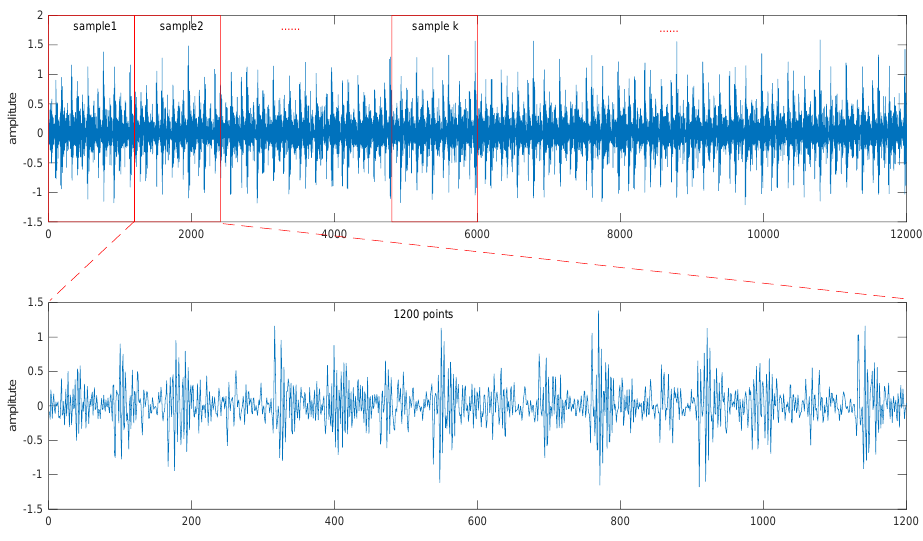
Figure 3. Segmentation of samples.